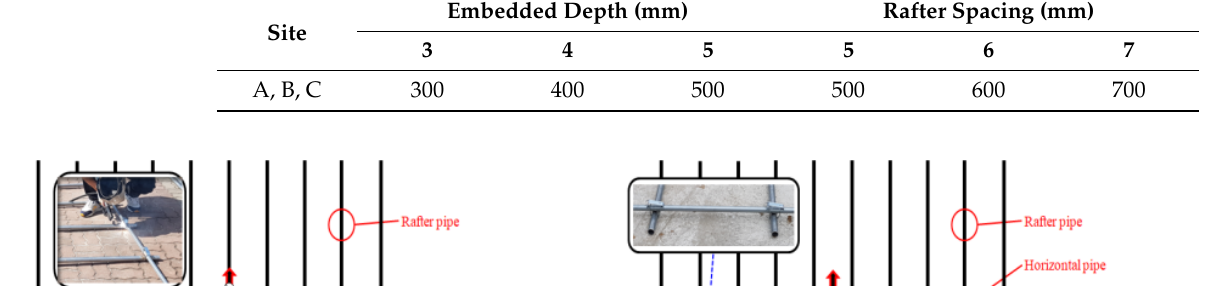
Table 3. Test condition identification number.